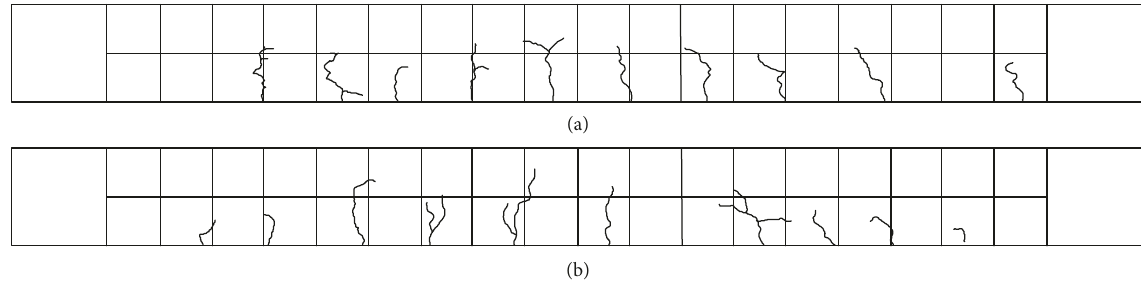
Figure 7: Crack patterns observed in RC beam specimens after the static test: (a) RC-SR; (b)